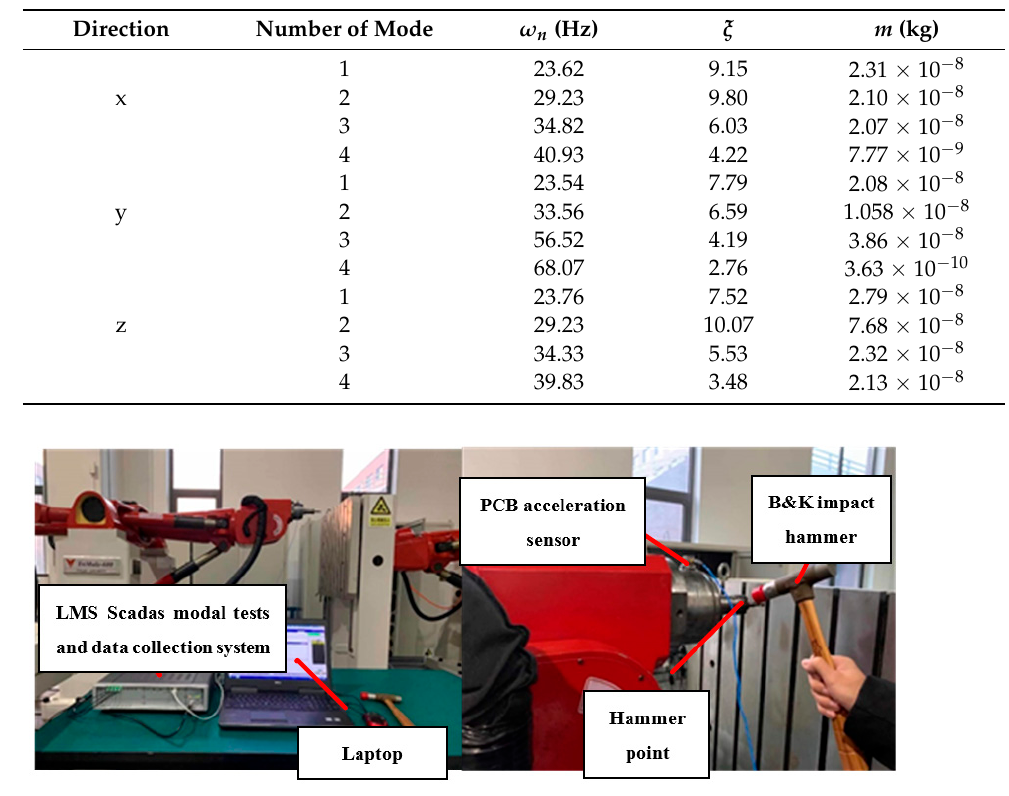
Figure 9. Experimental platform of TriMule based helical milling modal tests.